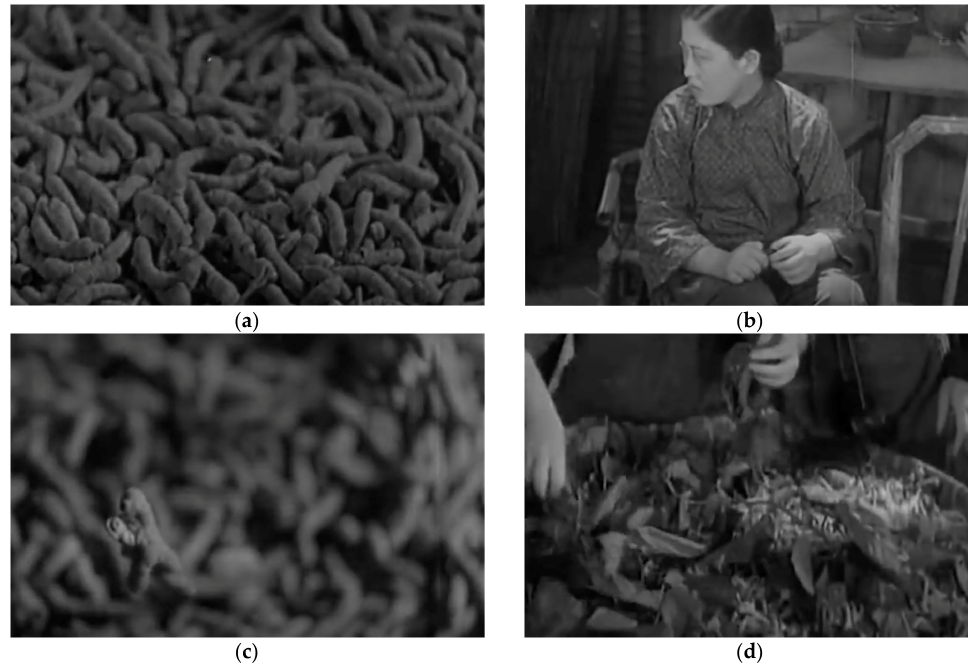
Figure 2. ( a ). Close-up of the silkworms awaiting a delivery of more mulberry leaves (49:45). ( b ) Ah Si’s wife stares anxiously at the hungry silkworms (49:55). ( c ) Focus on one individual hungry silkworm (50:45). ( d ) The mulberry leaves finally arrive, and the silkworms are fed (52:35). Image copyright: all images in public